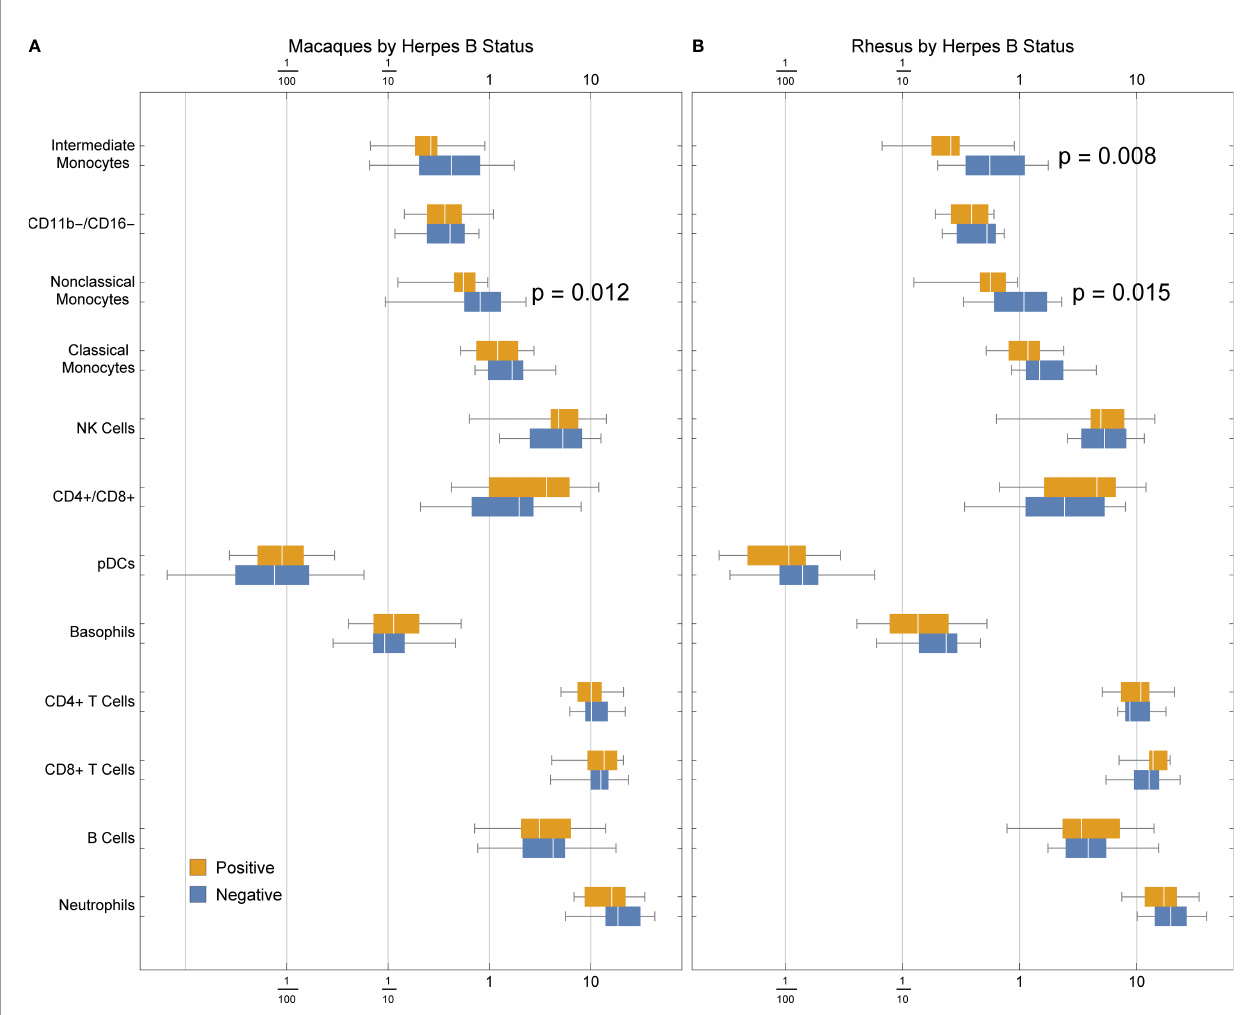
FIGURE 6 | Frequencies of cell types in (A) rhesus and cynomolgus macaques or (B) rhesus macaques only, by herpes B virus status. P values were calculated between serostatus groups using a one-tailed Mann-Whitney U